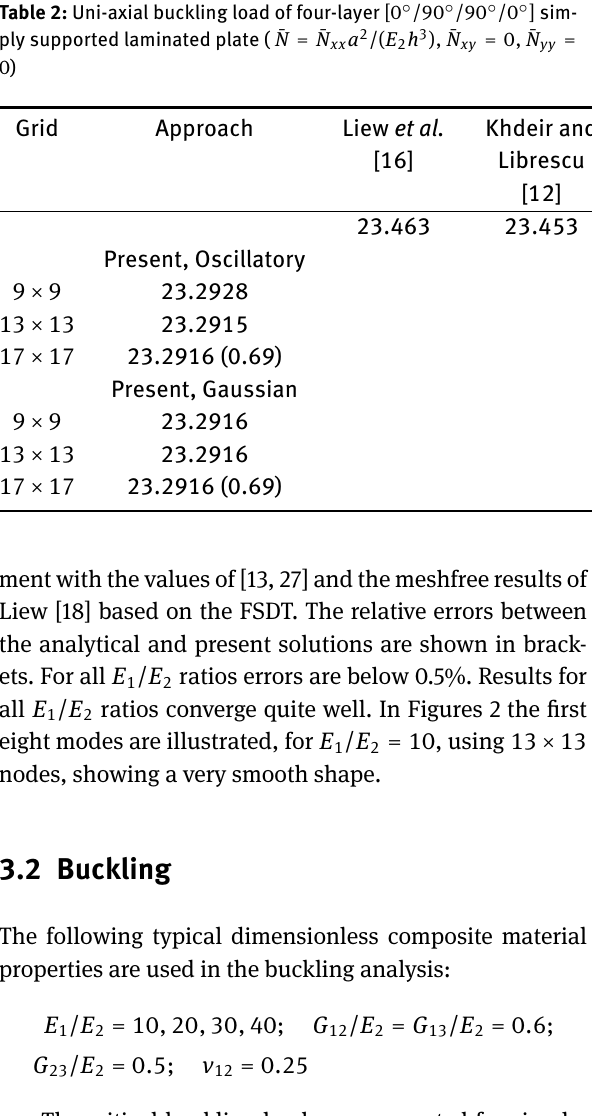
Table 2: Uni-axial buckling load of four-layer [0 ∘ /90 ∘ /90 ∘ /0 ∘ ]